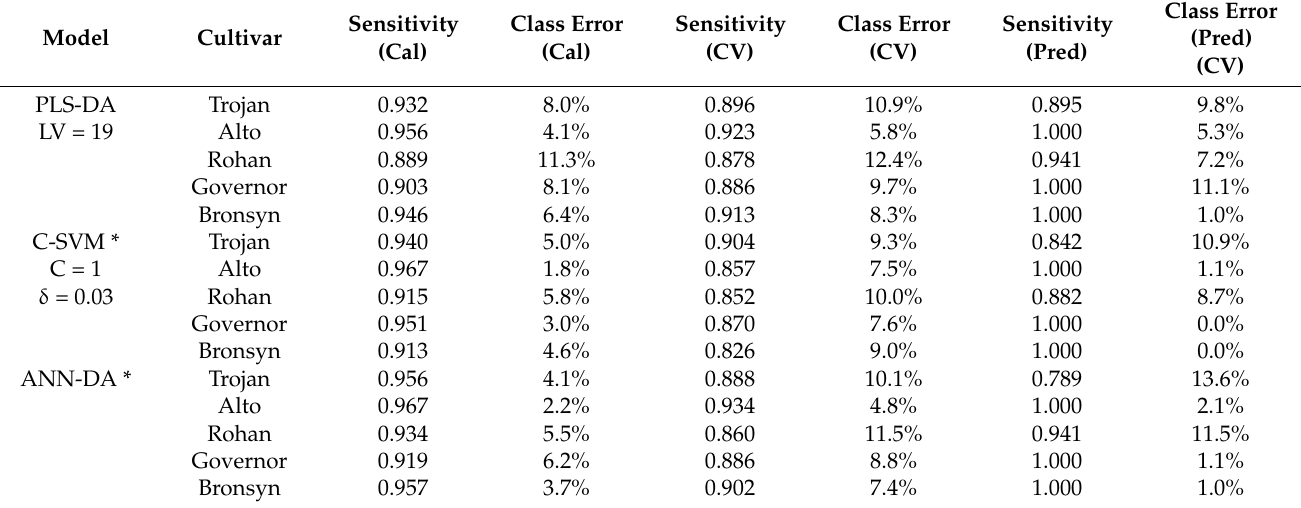
Table 6. Classification models using 87 optimal wavebands for cultivars Trojan ( n = 366); Alto ( n = 91); Rohan ( n = 271); Governor ( n = 185) and Bronsyn ( n = 92) calibration dataset and Trojan ( n = 19); Alto ( n = 5); Rohan ( n = 17); Governor ( n = 7) and Bronsyn ( n = 4) prediction